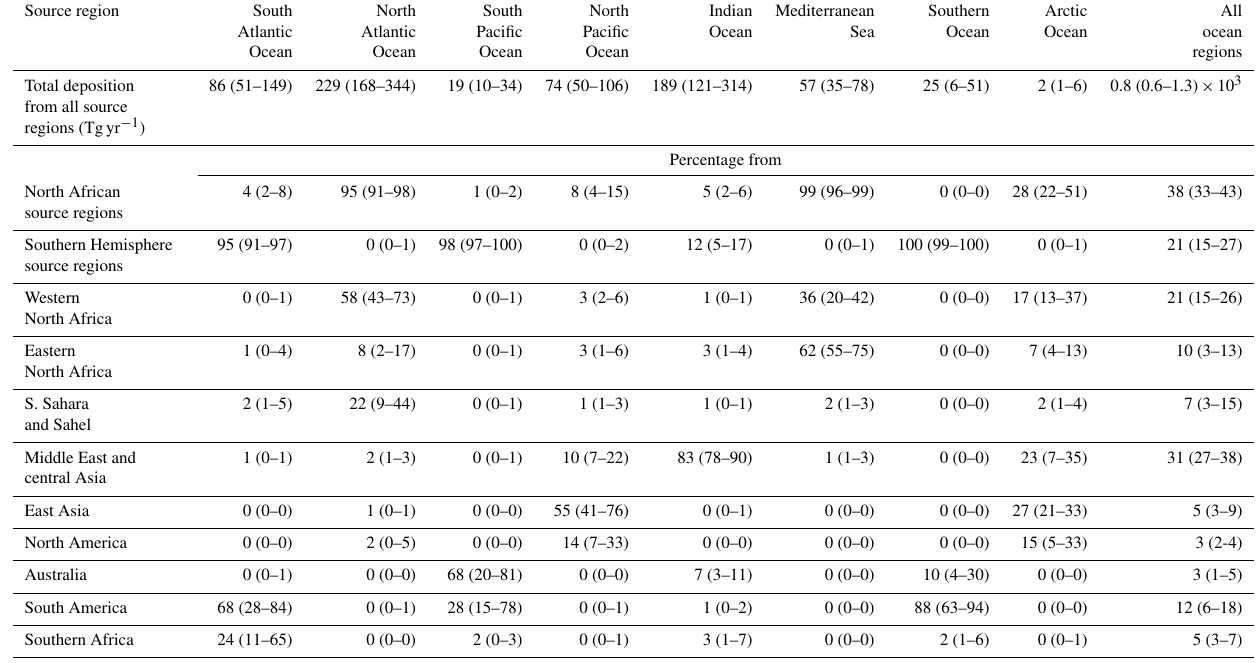
Table 3. Constraints on the contribution of dust deposition from each source region to the world’s main ocean basins. Listed are median values, with 1 standard error intervals listed in parentheses. Coordinates of ocean basins are based on NOAA’s World Ocean Atlas (Locarnini et al., 2010). All regions are plotted in Fig. S24 for